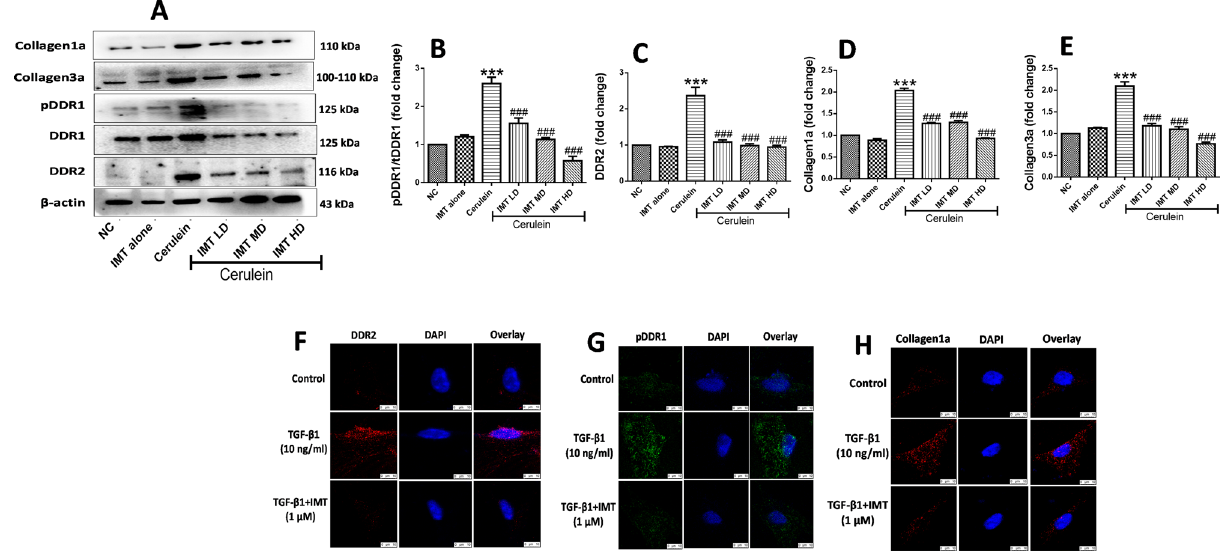
Figure 3. Inhibition of DDR1 and DDR2 expression prevents progression of pancreatic fibrosis. ( A–E ) Western blot and corresponding densitometric analysis of protein expression of phosphorylated DDR1, total DDR1, DDR2, collagen1a and collagen3a in pancreatic tissue. ( F–H ) Immunofluorescence (IF) staining for phosphorylated DDR1, DDR2 and collagen1a in TGF-β1-induced PSCs. β-actin was used as loading control. All values are represented as mean ± SEM (n = 3). Statistical significance was established using one-way ANOVA followed by Tukey’s multiple comparisons test where ***P < 0.001 vs Normal control, ### P < 0.001 vs Cerulein. Full-length blots are presented in Supplementary Fig.